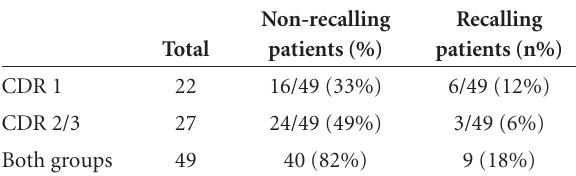
Table 4. Cluster recalling in CDR